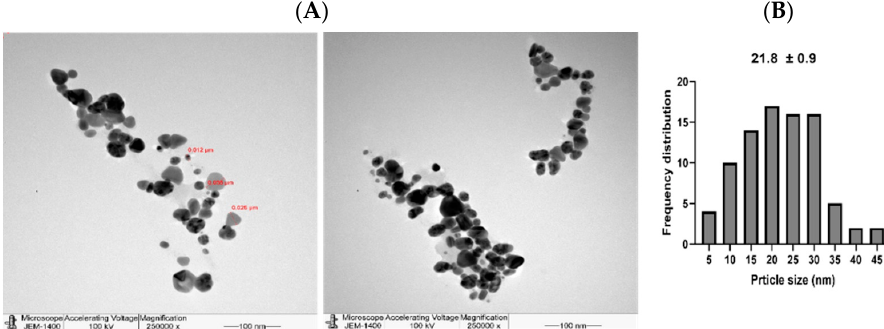
Figure 5. Spherical shape L-AgNPs ( A ) and their frequency distribution with mean particle size ( B ). Size measurements were analyzed by ImageJ software constructed from TEM micrographs at scale bars: 100 nm.